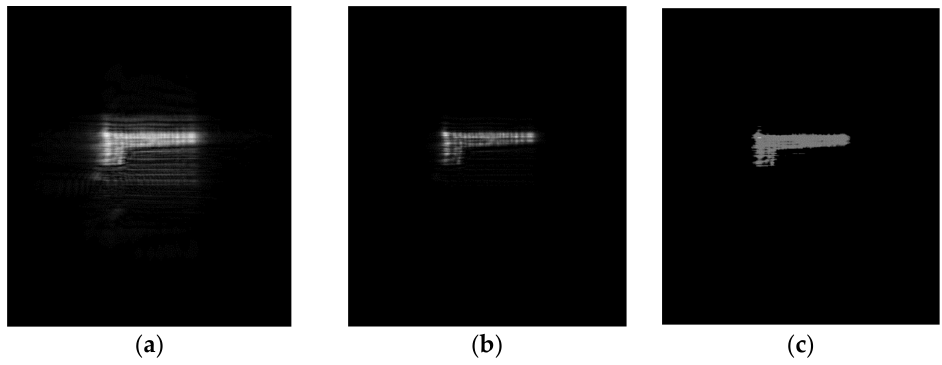
Figure 10. ( a ) Reconstruction of the image; ( b ) gamma transform algorithm with coefficient of 2.4 is used to process the original image; ( c ) the original image is linear stretching algorithm after gamma algorithm.